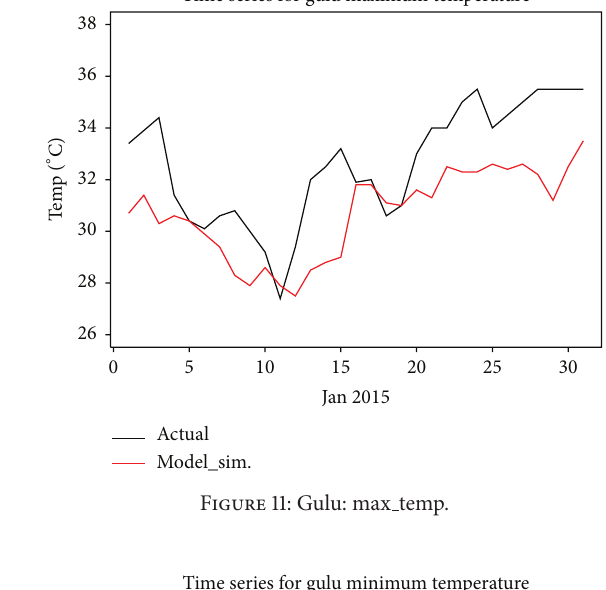
Figure 9: Mbarara: max temp.